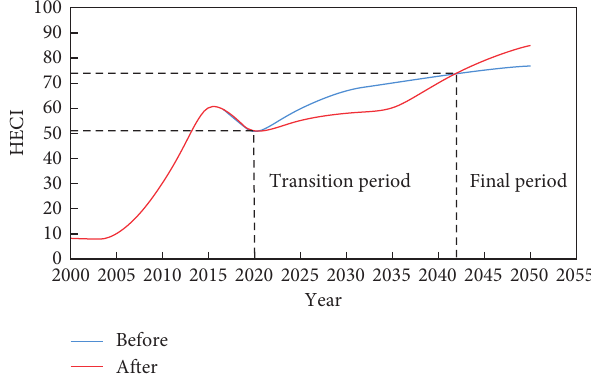
Figure 7: The effect of reforms in the transitional and final